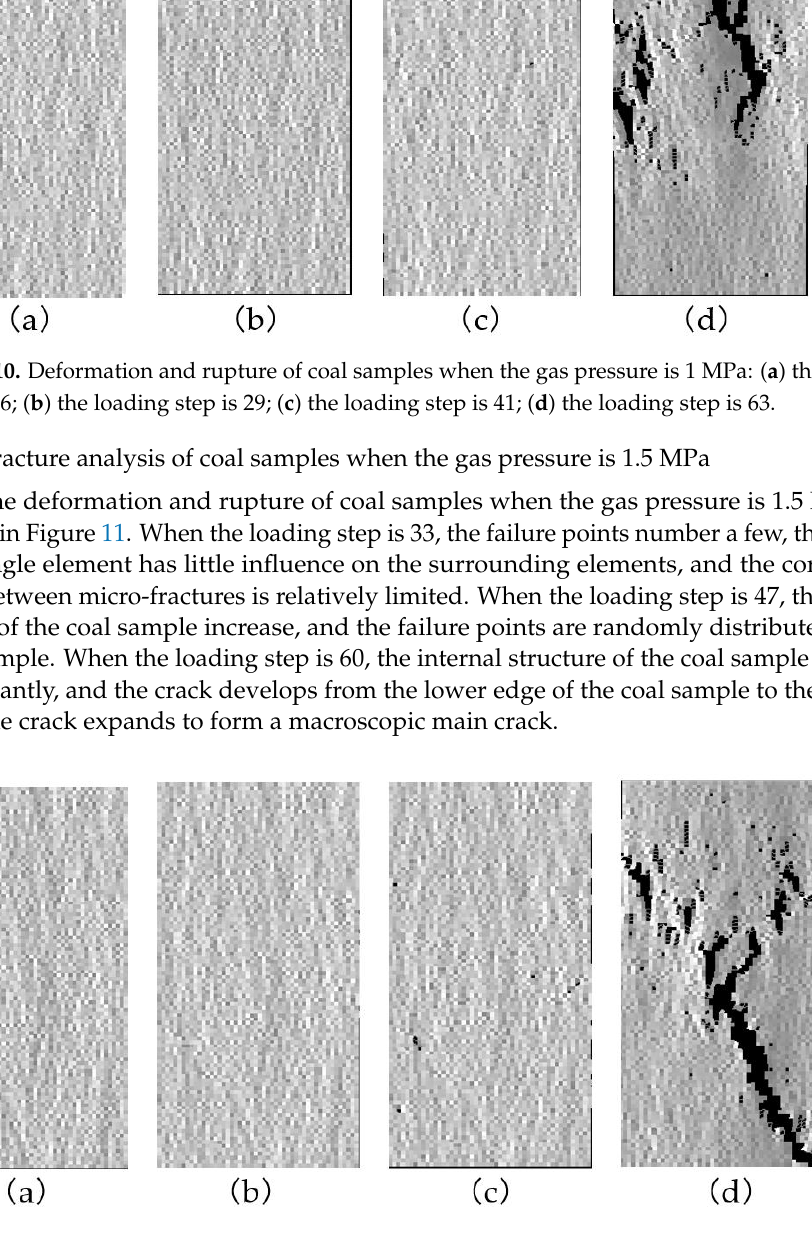
Figure 11. Deformation and rupture of coal samples when the gas pressure is 1.5MPa: ( a ) the loading step is 15; ( b ) the loading step is 33; ( c ) the loading step is 47; ( d ) the loading step is 60.